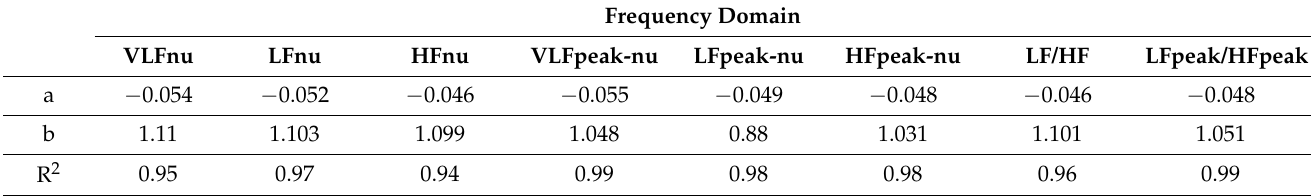
Table A6. Spearman’s Correlation Test—Linear Regressions of the Mean Correlations (subpart